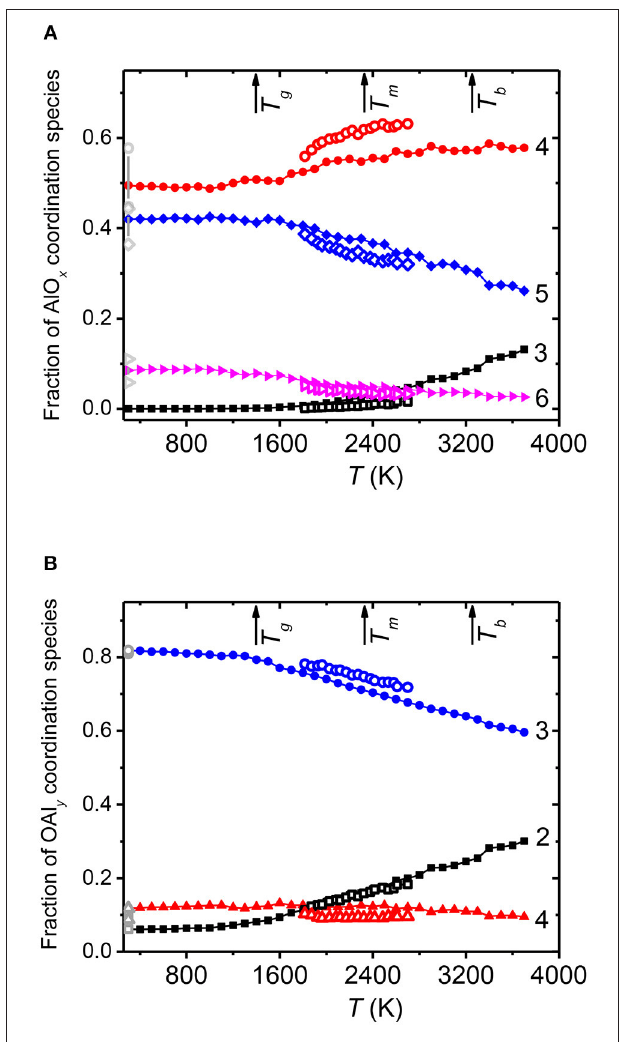
FIGURE 9 | The temperature dependence of the distribution of (A) AlO x units (where x = 3, 4, 5, 6) and (B) OAl y units (where y = 2, 3, 4) from the MD simulation (solid symbols) and EPSR models (open symbols) obtained using r 2 = 2.5 Å. The corresponding AlO x and OAl y distributions in amorphous alumina from EPSR models at 300K are plotted as gray symbols, with densities of 2.99 and 3.22g cm − 3 leading to the ranges shown. The arrows indicate the glass transition temperature, T g = 1,395K, from the MD simulation, together with the experimental melting point, T m = 2,327K, and boiling point T b = 3,250K of Al 2 O 3 (Taylor et al., 1992). We note that the MD model remains liquid up to the highest temperatures